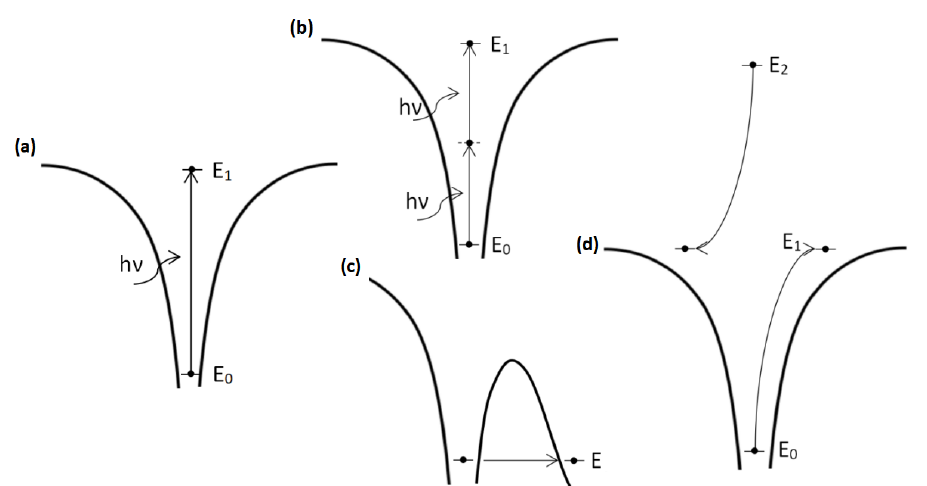
Figure 1. Principle schemes of main nonlinear processes: ( a ) linear ionization, ( b ) nonlinear (multi- photon) ionization, ( c ) tunneling ionization and ( d ) avalanche